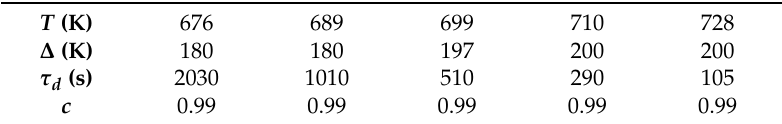
Table 2. The results of theoretical processing of experimental data [11] on the kinetics of hydrogen desorption from the Si(100)2 × 1 surface at di ff erent temperatures and the initial condition θ (0) = 0.15 (Figure 3). The values of the characteristic parameters τ d , ∆ , and c were found by approximating the data [11] according to Equation (13) with the use of the least squares method. T